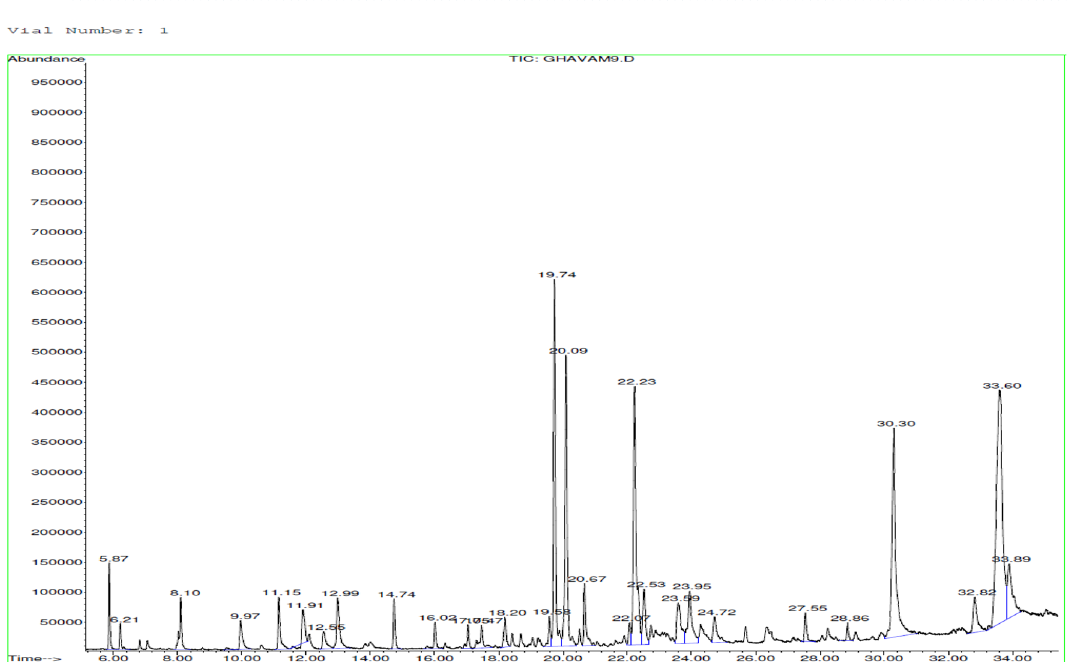
Figure 4. GC–MS chromatogram of essential oil obtained from Stachys